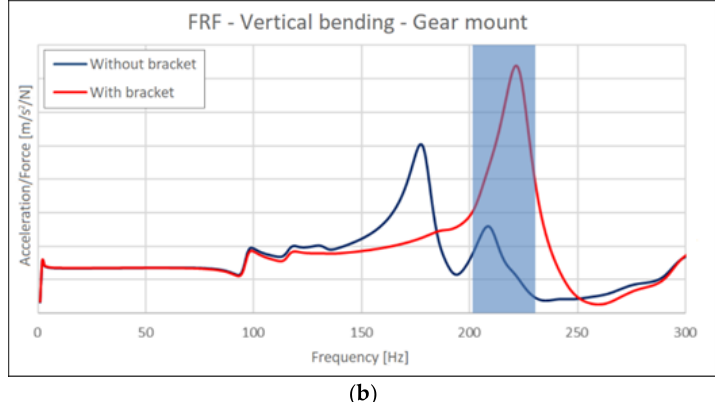
Figure 4. Acceleration / force ratio for the full FEM model for the vertical bending load case with and without the crankcase–gearbox bracket (shown in Figure 3) at: ( a ) engine mount; ( b ) gear mount.